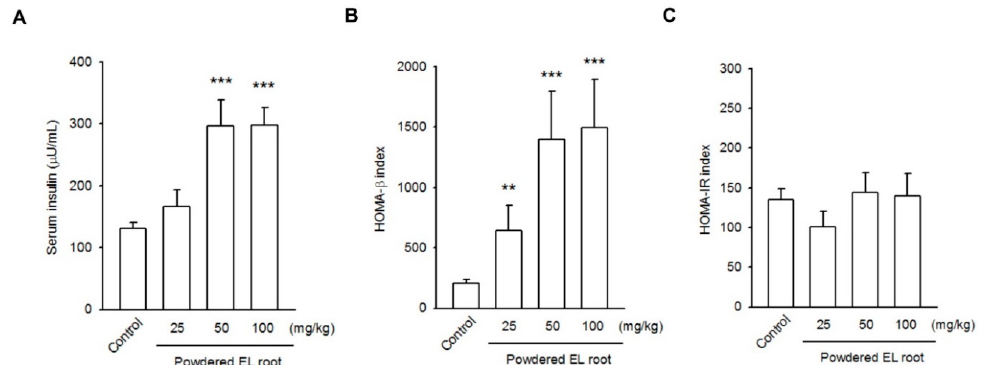
Figure 7. E. longifolia enhanced beta-cell performance, resulting in an improvement of insulin secretion. ( A ) The elevations of serum insulin level were detected in the 50 and 100 mg / kg administrated groups. By using a mathematical approach, the HOMA- β index ( B ) and HOMA-IR index ( C ) were used to assess β -cell function and insulin resistance, respectively. No statistical di ff erence was found in the HOMA-IR index among the control and EL-treated groups. However, HOMA- β was notably increased in the EL-treated groups, as compared to that in the control. These data a ffi rmed that EL may improve islet performance either by an induction of PDX1 or by the increase in beta cell number. (** p < 0.01, *** p < 0.001, indicates a statistically significant di ff erence from the control group).